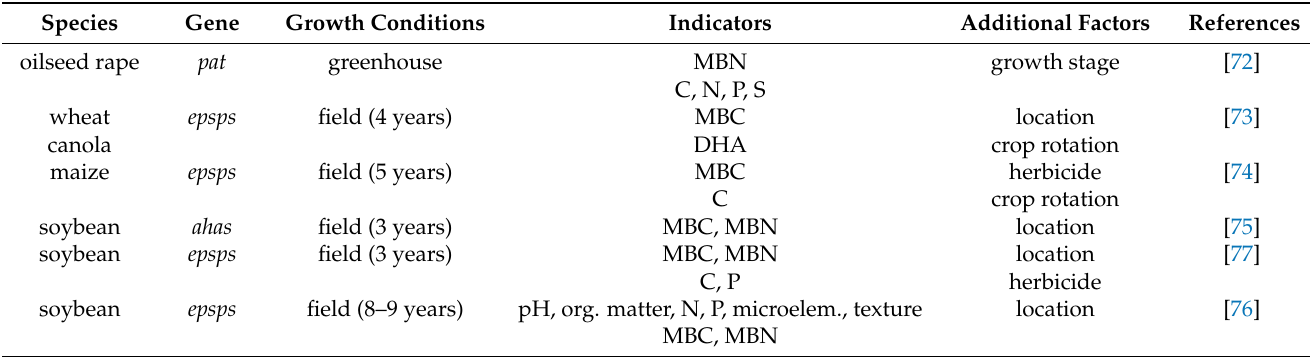
Table 2. Risk assessment of herbicide-resistant transgenic plants on soil